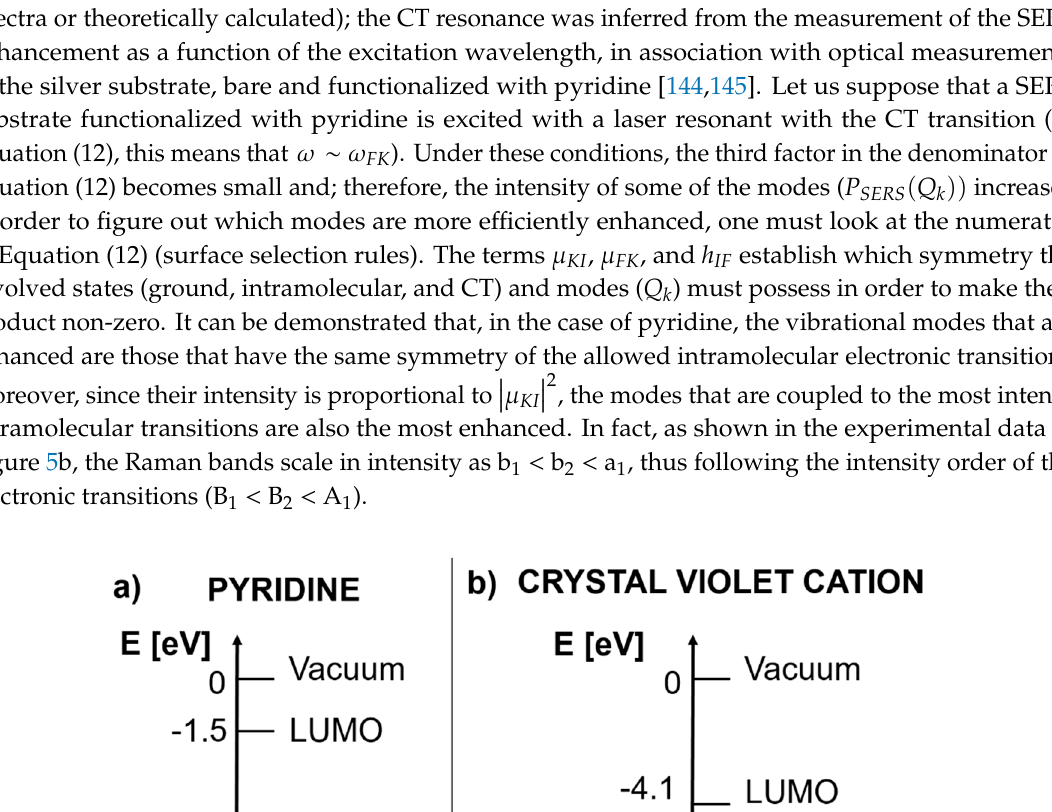
Figure 5. ( a ) Spectral distribution of the plasmonic (red line), charge transfer (CT, black line), and intramolecular (green, blue, and violet lines) resonances for pyridine adsorbed on silver. Reprinted (adapted) with permission from Lombardi et al. [9]. Copyright (2008) American Chemical Society. ( b ) SERS spectrum of pyridine on silver. Reprinted (adapted) with permission from Lombardi et al. [137]. Copyright (2008), American Chemical Society. Another instructive example is the crystal violet cation (CV + ): It is a dye which has been often used for single molecule studies [14,146,147] and as a Raman reporter molecule [148,149], due to its very large Raman cross-section. Its energy diagram is illustrated in Figure 4b. The energy of the frontier orbitals have been estimated by means of electrochemical methods [146]. The main CV + intramolecular resonance and the CT state that is formed upon interaction with silver are shown in Figure 6. It can be noticed that, once excited with the common He-Ne laser (excitation at 633 nm),